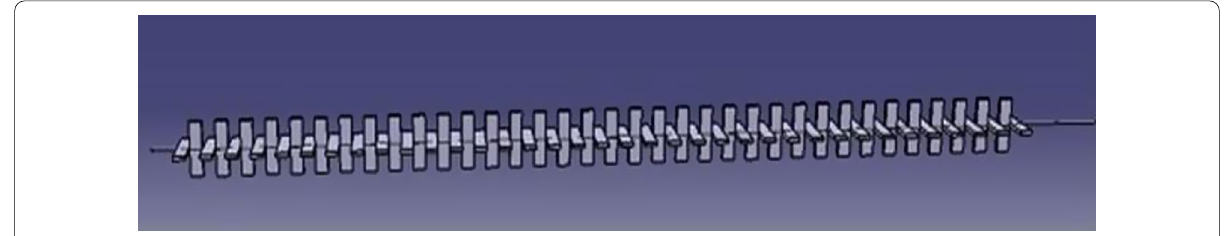
Fig. 5 Tube insert by using the T-TT, Tri, T-Rec, and T-Tra